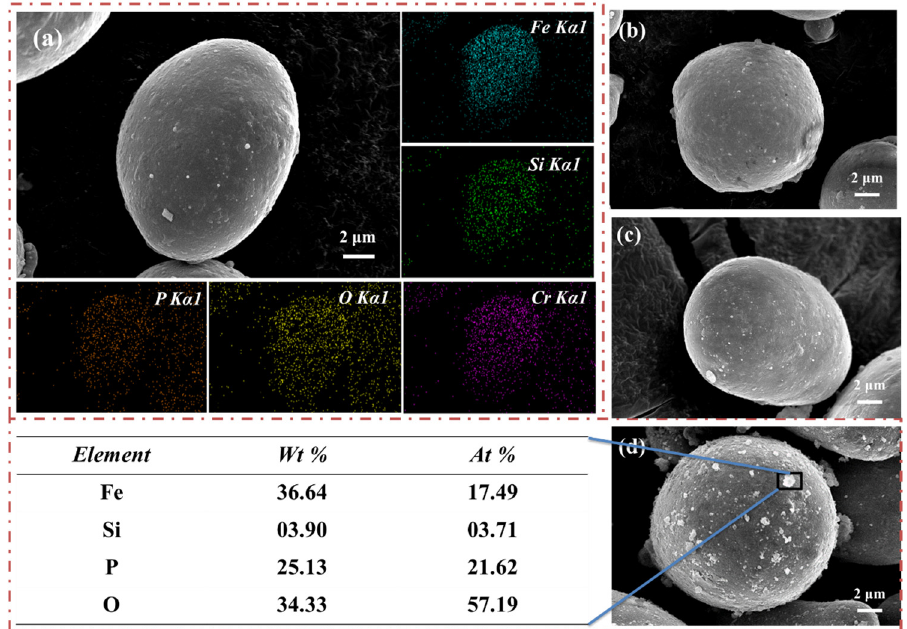
Figure 4. SEM images of the powders phosphated by different H 3 PO 4 concentrations ( a ) 0.25 wt.%, ( b ) 0.5 wt.%, ( c ) 0.75 wt.%, and ( d ) 1.0 wt.%. The EDS result of powder phosphated by H 3 PO 4 concentration of 0.25 wt.% is also shown in the figure. Table 1. Effective permeability µ e , Q and core loss P s of the SMCs with 0.5 wt.% H 3 PO 4 -ethanol solution and different concentration of sodium silicate-aqueous